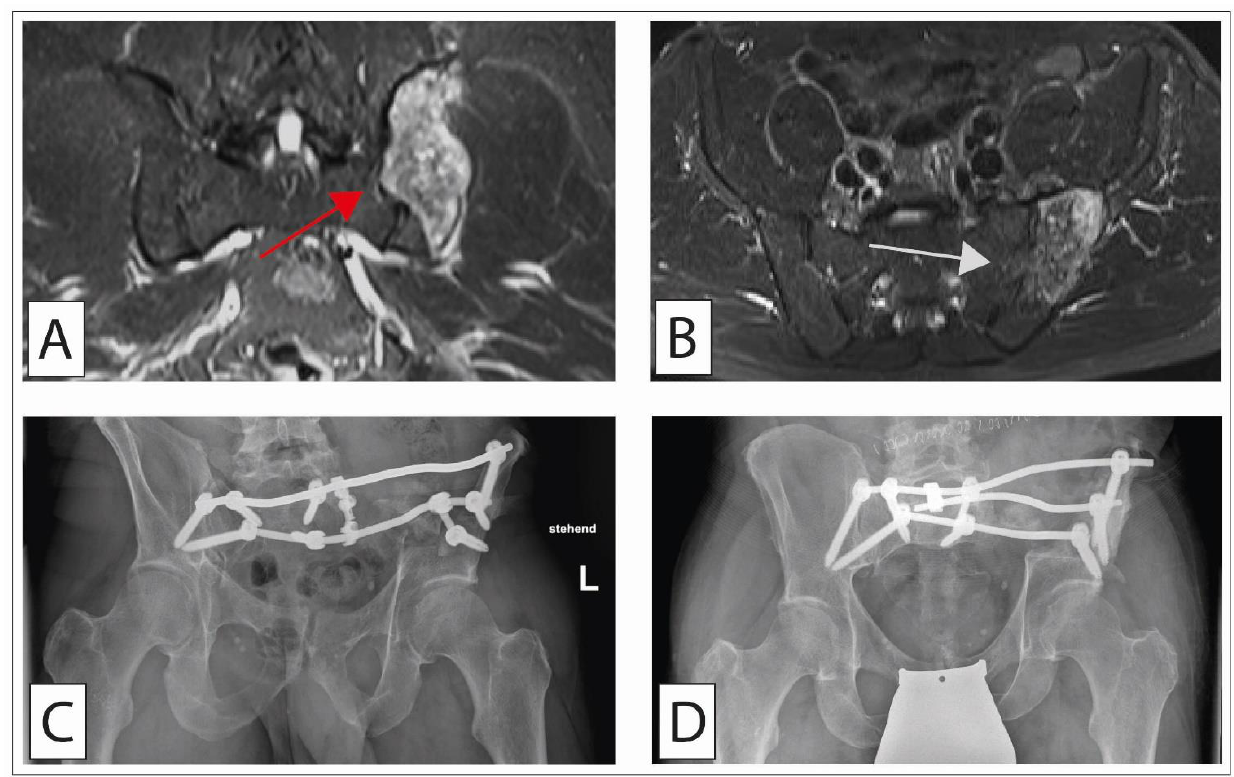
Figure 5. Chondrosarcoma of the pelvis treated with wide resection and reconstruction with allogenic and autologous bone graft. A 56-year-old patient presented in the ward with local low back pain. MR imaging showed a bone tumor in the postero-medial iliac crest (red arrow) with transgression of the sacroiliac joint (white arrow) (T2 tirm coronal ( A ) and axial ( B )). Histopathological analyses after open biopsy showed a G1 chondrosarcoma with no other foci after staging. ( C ) En bloc resection was performed with a transiliacal osteotomy laterally and an osteotomy along the neuroforamina of the sacrum. Reconstruction was performed with a screw–rod system with three pedicle screws brought into the remaining iliac bone/acetabulum on the left and, on the right side, one S1 screw, one ilium screw, and one S2 ala-ilium screw. Allogenic bone was brought into the site of resection, augmented by an autologous rib. After 3 months of partial-weight bearing, the patient was allowed full-weight bearing. One year postoperatively, the patient had to be revised with a broken rod and incomplete osseointegration of the graft material. ( D ) Screw augmentation plus additional rod implantation were performed, accompanied by new autologous cancellous bone grafting. As an alternative procedure to the BMP-9 rich autologous rib, a vascularized fibula graft or the Capanna technique might have been used in this patient.